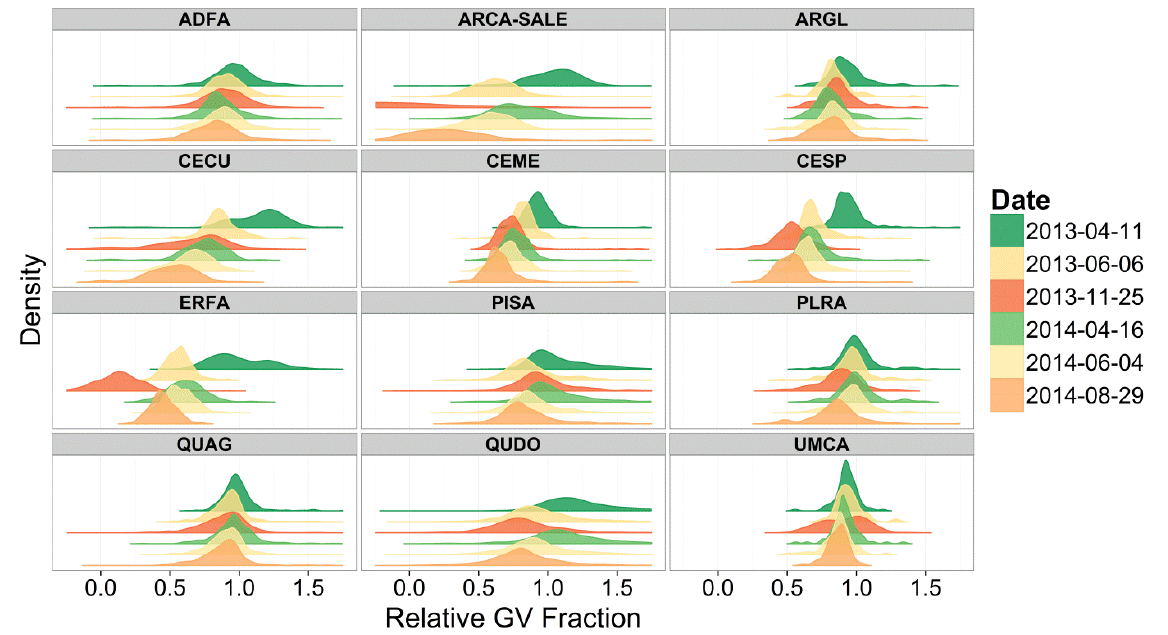
Figure 6. Relative GV fraction distributions for individual species. Species codes are listed in Table 1. Density is the kernel density estimate calculated using the “density” function in R statistical software (http://www.R-project.org/).